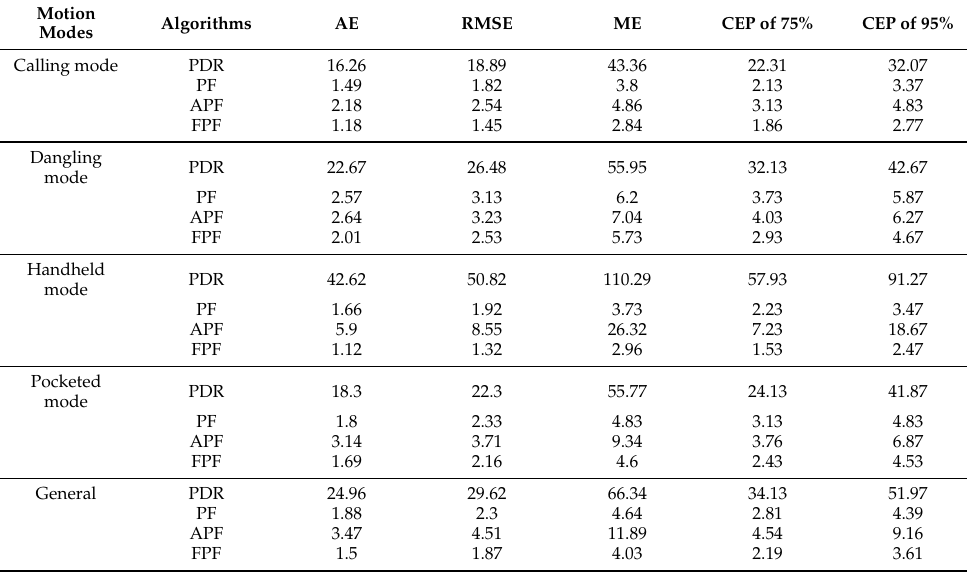
Table 3. Position errors for PDR, PF, APF, and FPF